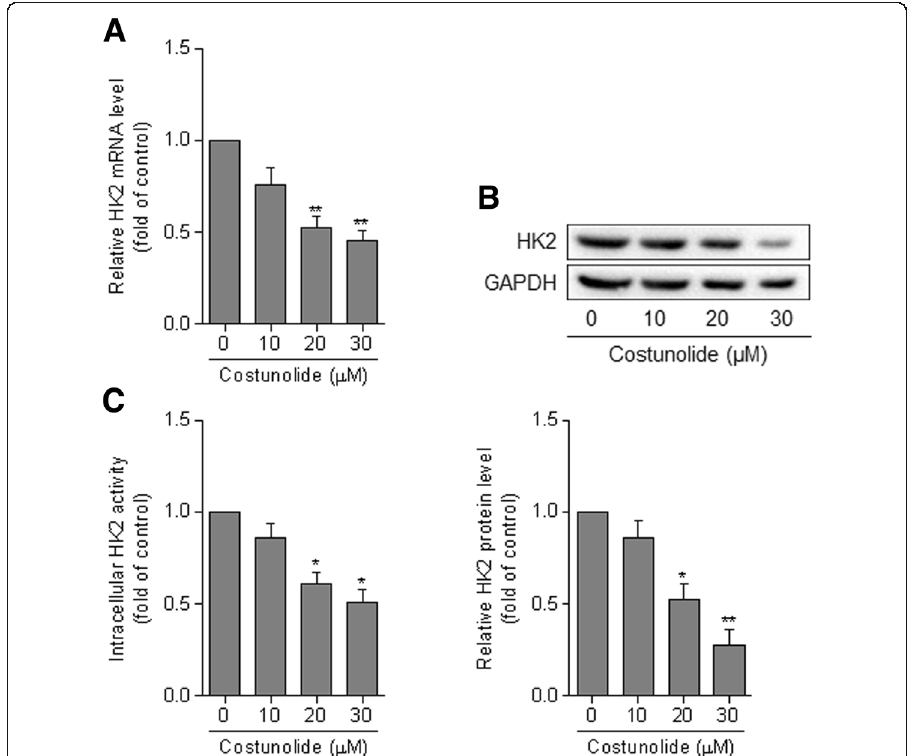
Fig. 4 Costunolide suppresses the expression and activity of HK2 in HSCs. Primary rat HSCs at passages 3 through 5 were treated with costunolide at the indicated concentrations for 24 h. a – Real-time PCR for determining the mRNA expression of HK2. b – Western blot assay for determining the protein expression of HK2 with quantification of the blots. c – Measurement of the intracellular activity of HK2. Statistics: * p < 0.05, ** p < 0.01 vs. control